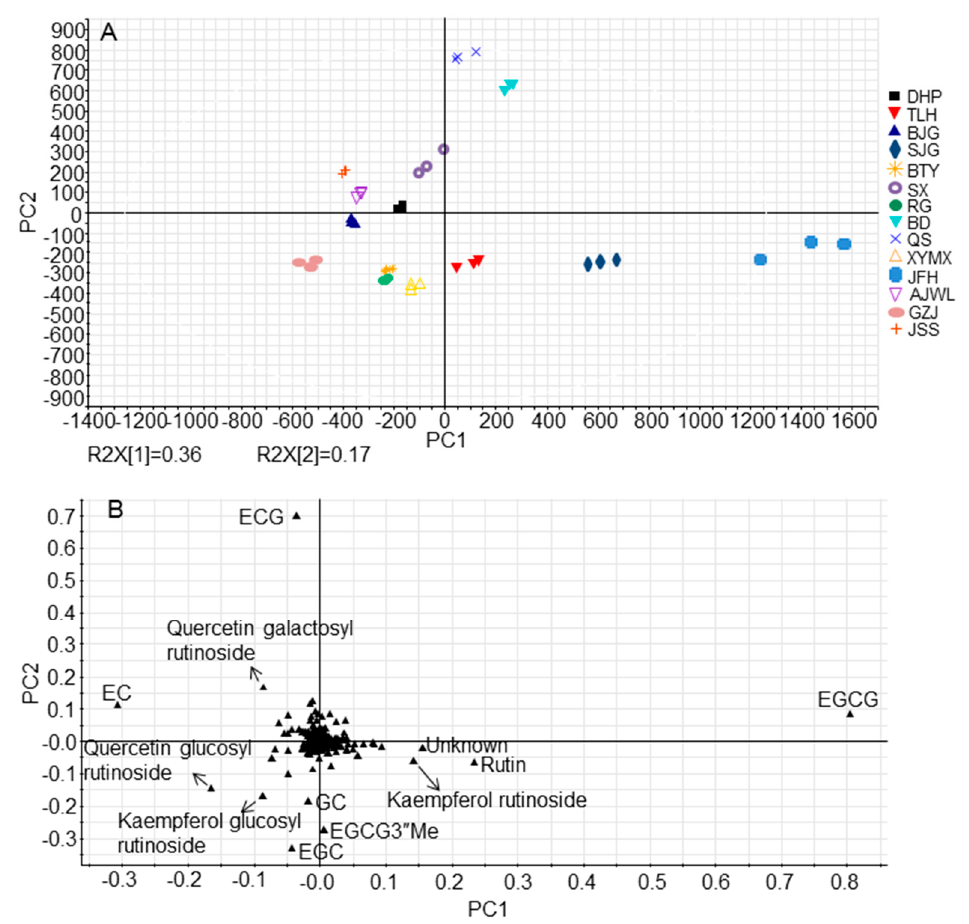
Figure 3. Principal component analysis (PCA) of methanol extracts of tea leaves. ( A ) Score plot of PCA demonstrating differences in metabolite profiles between leaf samples based on 466 filtered single molecular features detected by UPLC-QTOF MS in ESI − . The principal components 1 and 2 explained 36.0% and 17.0% of total variance, respectively. For each cultivar, three biological replicates were prepared, where one replicate was a pool of 7–8 tea leaves. R2X, explained variation; ( B ) Loading plot of PCA indicating primary differential metabolites.